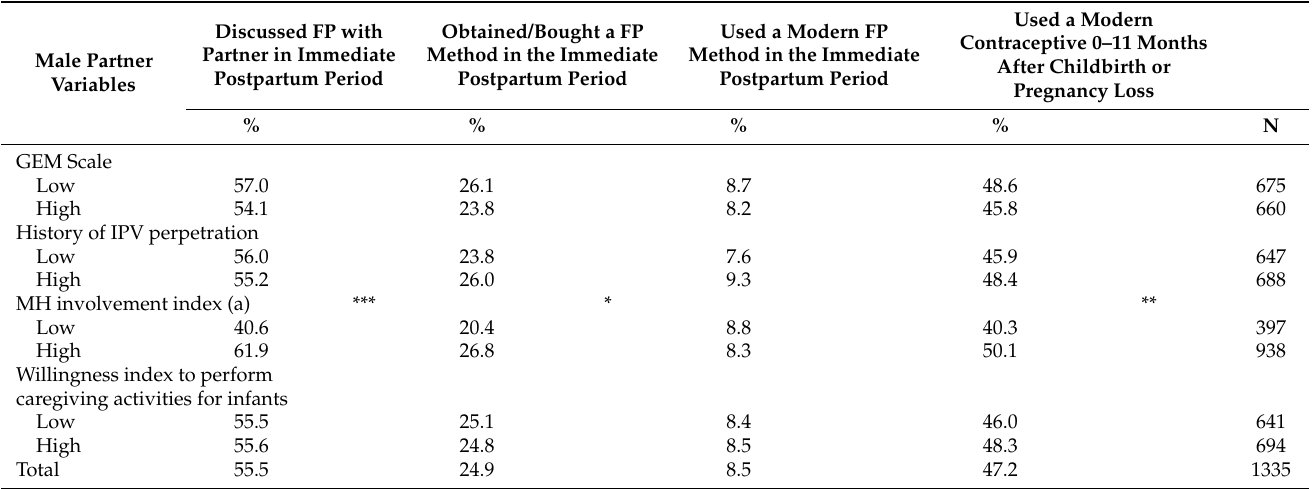
Table 2. Percent of FTMs with specific postpartum family planning outcomes by indicators of the male partner’s gender-equitable attitudes and behaviors, Kinshasa,